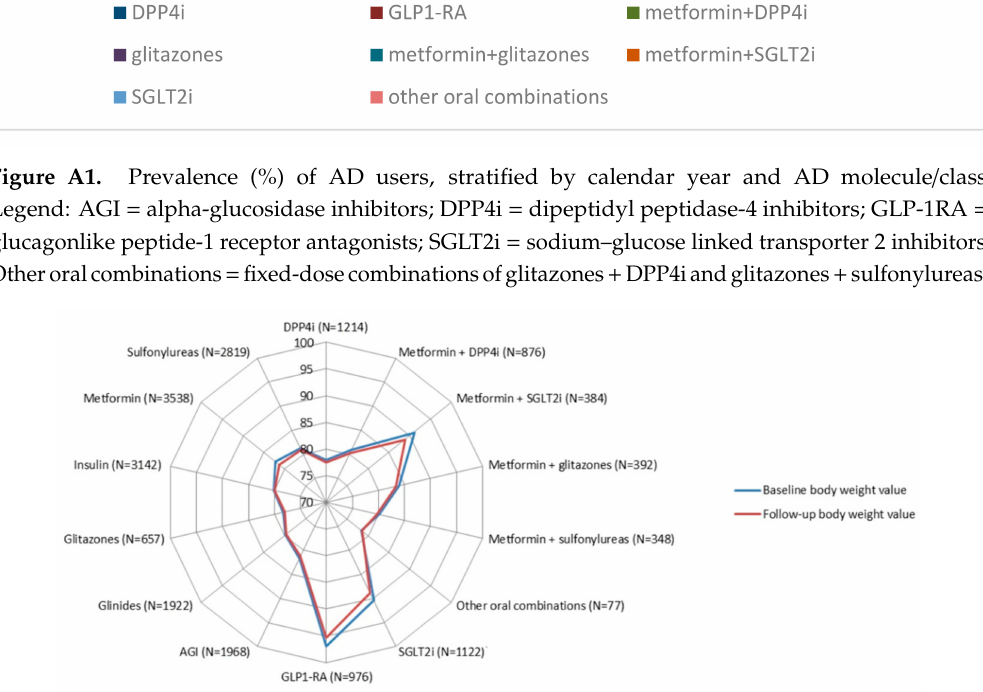
Figure A2. Comparison between the mean body weight values (kg) at baseline and within one year after ID, stratified by AD molecule / class. Legend: AGI = alpha-glucosidase inhibitors; DPP4i = dipeptidyl peptidase-4 inhibitors; GLP-1RA = glucagonlike peptide-1 receptor antagonists; SGLT2i = sodium–glucose linked transporter 2 inhibitors; Other oral combinations = fixed-dose combinations of glitazones + DPP4i and glitazones + sulfonylureas; ID = index date. All incident AD treatments with at least 12 months of follow-up were